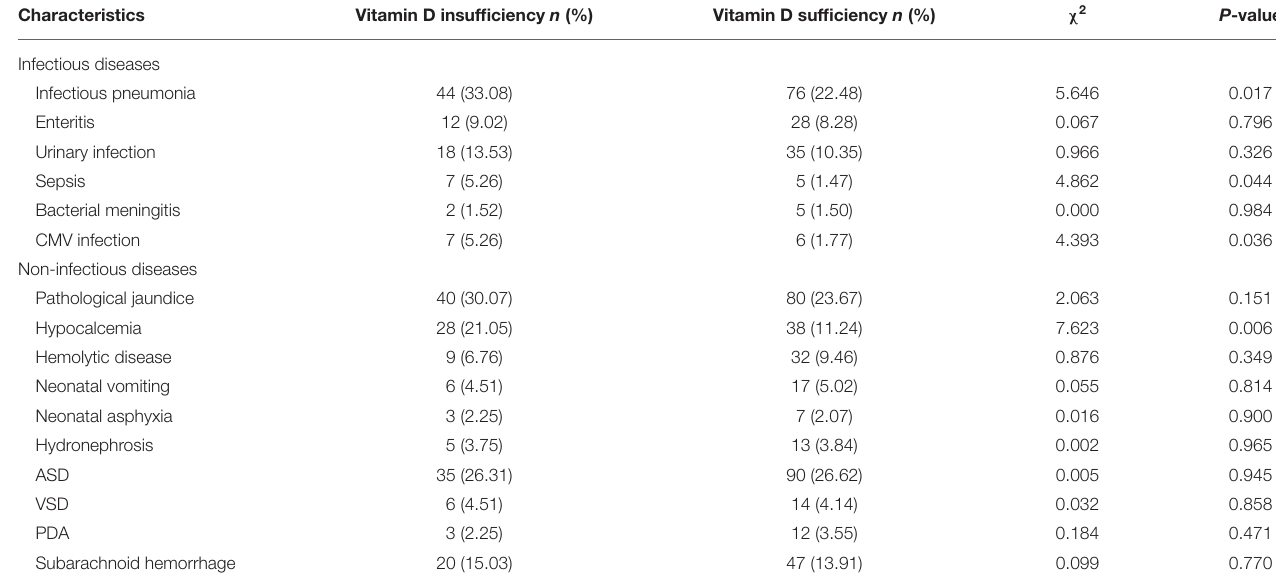
TABLE 5 | Comparison of vitamin D sufficient and insufficient groups.